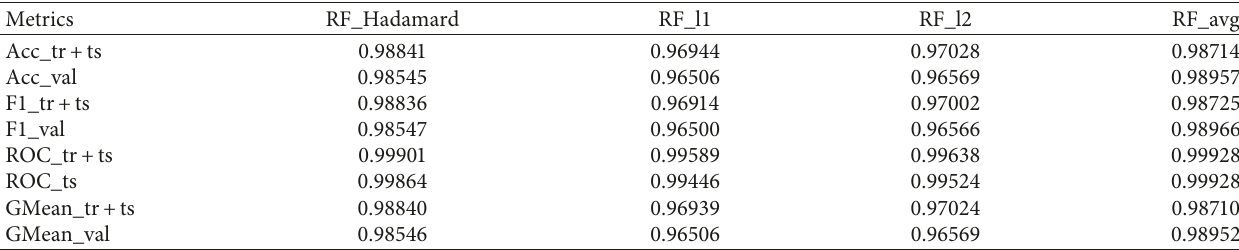
Table 15: For quoting interactions from April 12 until April 22 in 2021, utilizing the obtained embeddings through Node2Vec, performance of the RF model with operators Hadamard, l1, l2, and average 1